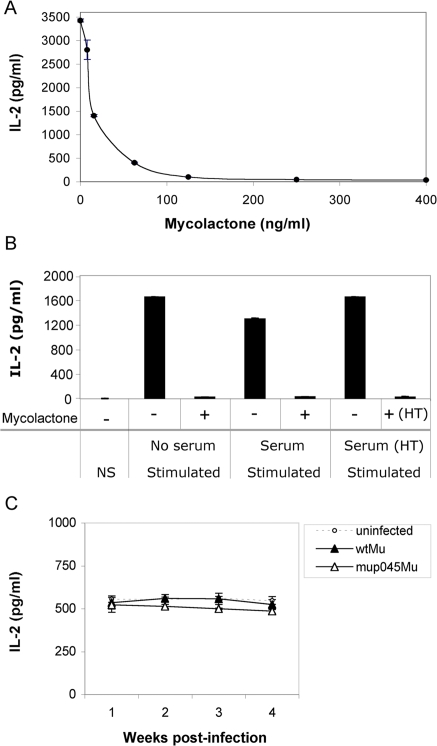
Presence of mycolactone in serum during M. ulcerans infection.
A) The dose-dependent immunosuppressive activity of mycolactone on the IL-2 production of Jurkat T cells is shown. IL-2 concentration was measured in culture supernatants of Jurkat T cells incubated with mycolactone A/B for 6 h prior to stimulation with PMA/ionomycin for 16 h. B) The effect of control mouse sera on stimulation-induced production of IL-2 by Jurkat T cells is shown, by comparison to cells incubated in the absence of serum. The graph shows that this inhibitory effect can be neutralized by heating the control mouse sera at 90°C for 10 min (HT), prior to addition onto Jurkat T cells. Controls include cells in the absence of stimulation (NS), and cells activated in the presence of sera spiked with mycolactone (400 ng/ml), then heat-treated. C) Immunosuppressive activity of sera harvested from mice infected with wild-type M. ulcerans (wtMu) or the mycolactone deficient mutant mup045Mu, as compared to sera from uninfected animals. Data are mean and SD of duplicate measurements of IL-2 production by Jurkat T cells activated in the presence of mouse sera (n = 4), and are representative of two independent experiments.